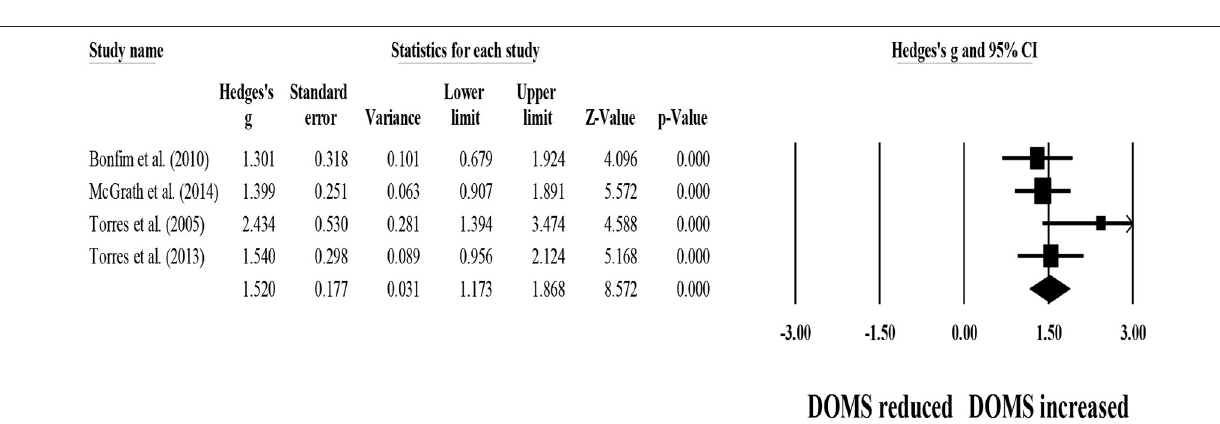
FIGURE 10 | Forest plot denoting 48-h post-exercise delayed onset of muscle soreness (DOMS) in participants that completed post-exercise passive recovery. Values shown are effect sizes (Hedges’s g) with 95% confidence intervals (CI). The size of the plotted squares reflects the statistical weight of each study. The black diamond reflects the overall result. Note: positive values denote that post-exercise passive recovery did not allow participants to recover their basal DOMS level (i.e., 0.00 in the